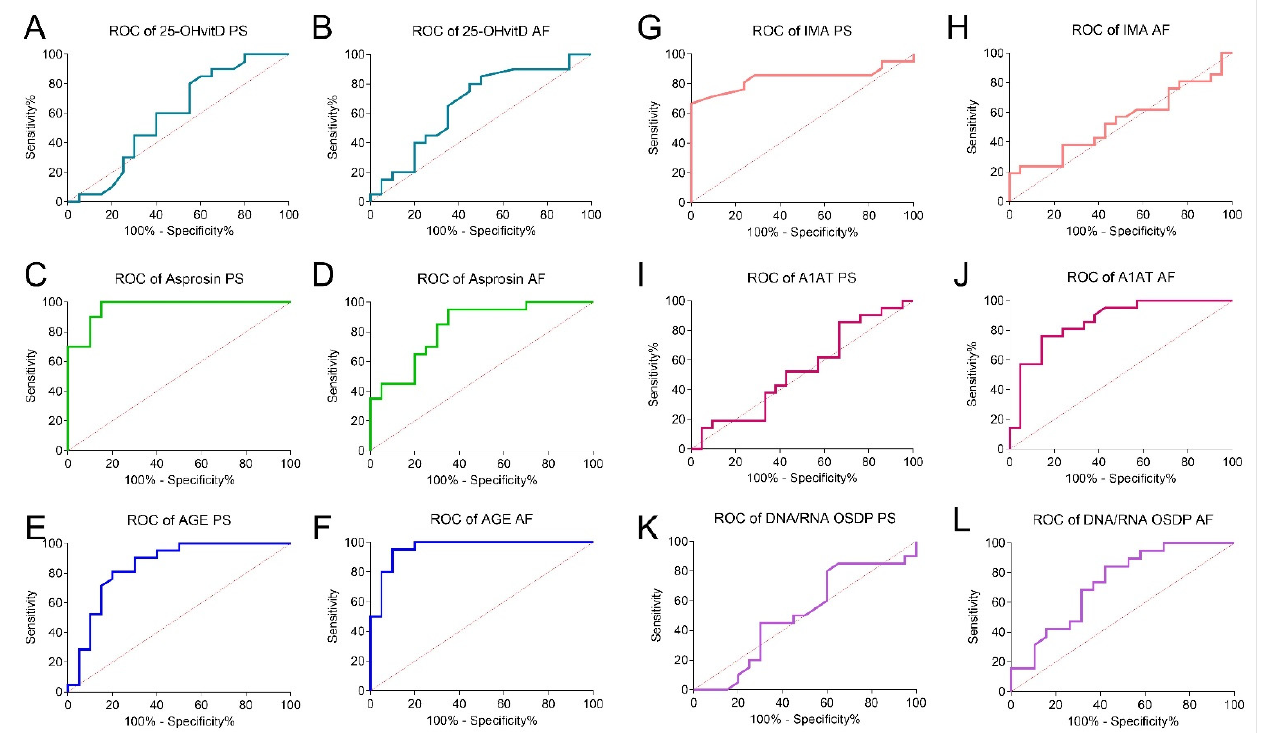
Figure 3. ROC curves of the studied parameters. ( A ) Plasma 25-OH vitamin D; ( B ) amniotic fluid 25-OH vitamin D; ( C ) plasma asprosin; ( D ) amniotic fluid asprosin; ( E ) plasma advanced glycation end products; ( F ) amniotic fluid advanced glycation end products; ( G ) plasma ischemia-modified albumin; ( H ) amniotic fluid ischemia-modified albumin; ( I ) plasma alfa-1-anitrypsin; ( J ) DNA/RNA oxidative stress damage product; ( K ) plasma DNA/RNA oxidative stress damage products; ( L ) amniotic fluid DNA/RNA oxidative stress damage products. AF, amniotic fluid; PS, plasma; OS, oxidative stress.